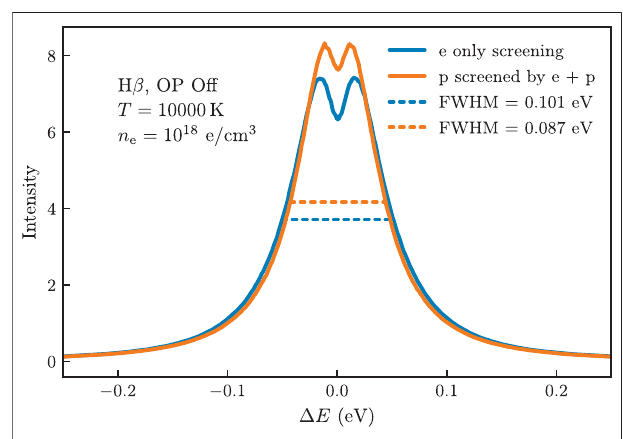
FIGURE 2 | The effect of screening on line shape of H β . Increasing the amount of screening experienced by the plasma particles yields narrower lines. Doubly screening ions by both ions and electrons produces a narrower pro fi le than singly screening both types of